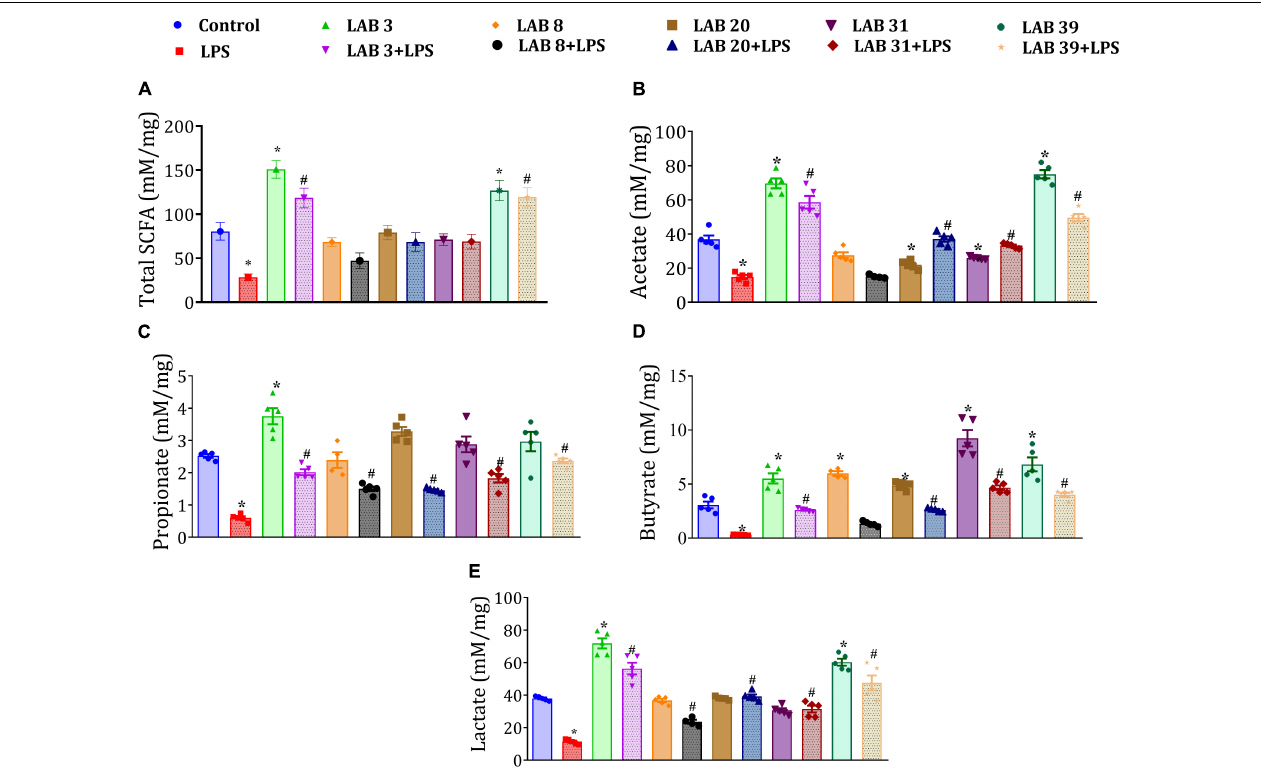
FIGURE 8 | Effect of LAB supplementation on the short-chain fatty acid (SCFA) production: (A) Total SCFA production; (B) acetate; (C) propionate; (D) butyrate; and (E) lactate. Data were analyzed by one-way ANOVA with Tukey’s post hoc test ( P ≤ 0.05) and are represented as mean ± SEM ( N = 5). *significant relative to control; # significant relative to the LPS